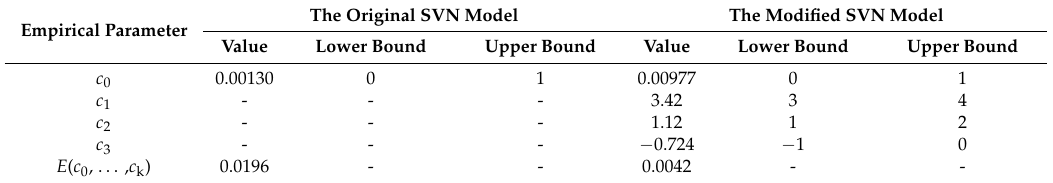
Table 3. Parameter calibration details for the modified and original models.